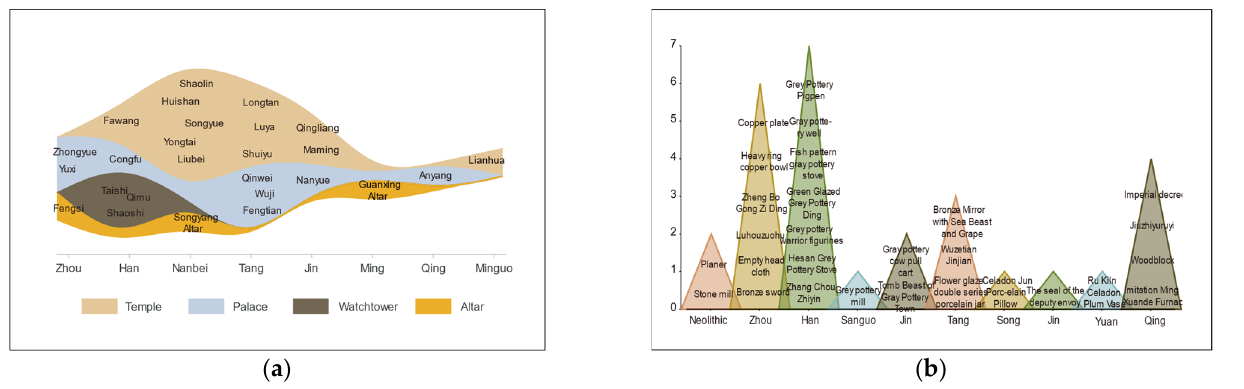
Figure 10. Time scale (Panel B) results: ( a ) changes in famous buildings over time; ( b ) changes in famous products over time.